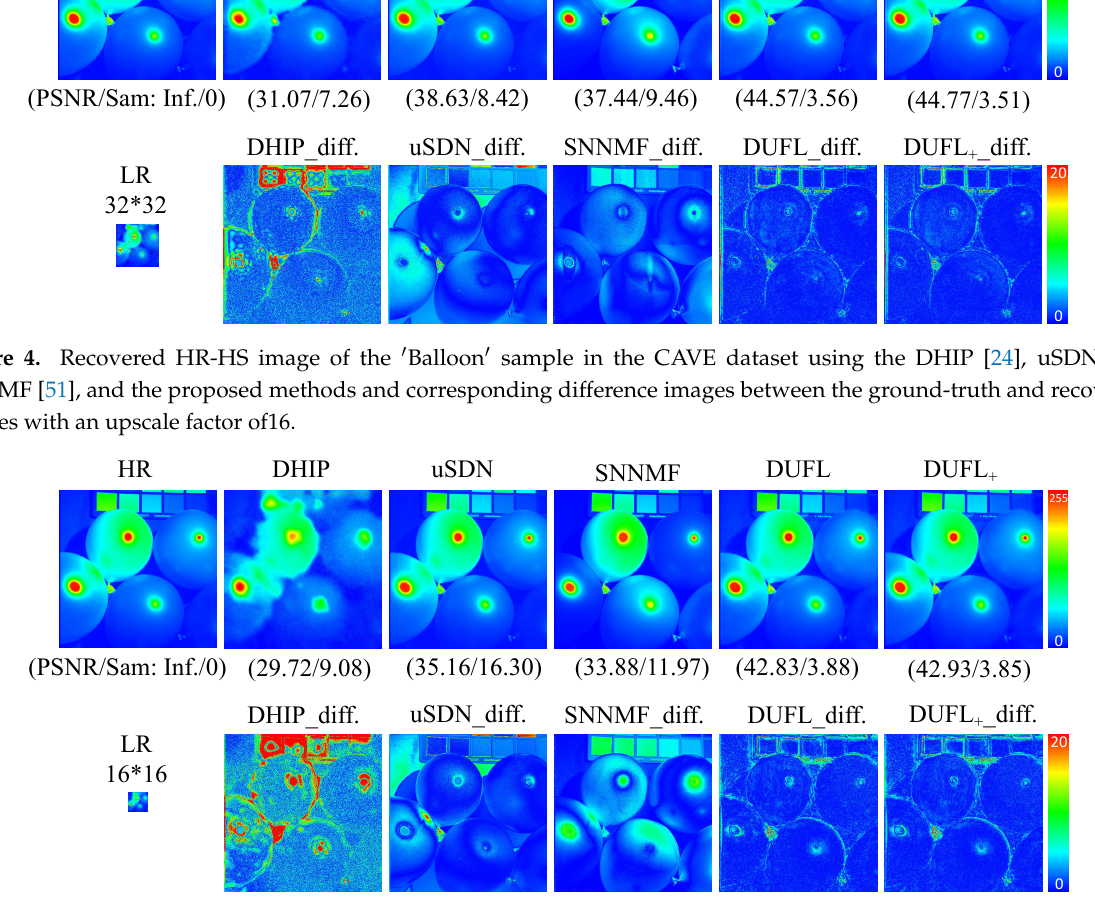
Figure 5. Recovered HR-HS image of the (cid:48) Balloon (cid:48) sample in the CAVE dataset using the DHIP [24], uSDN [41], SNNMF [51], and the proposed methods and corresponding difference images between the ground-truth and recovered images with an upscale factor of